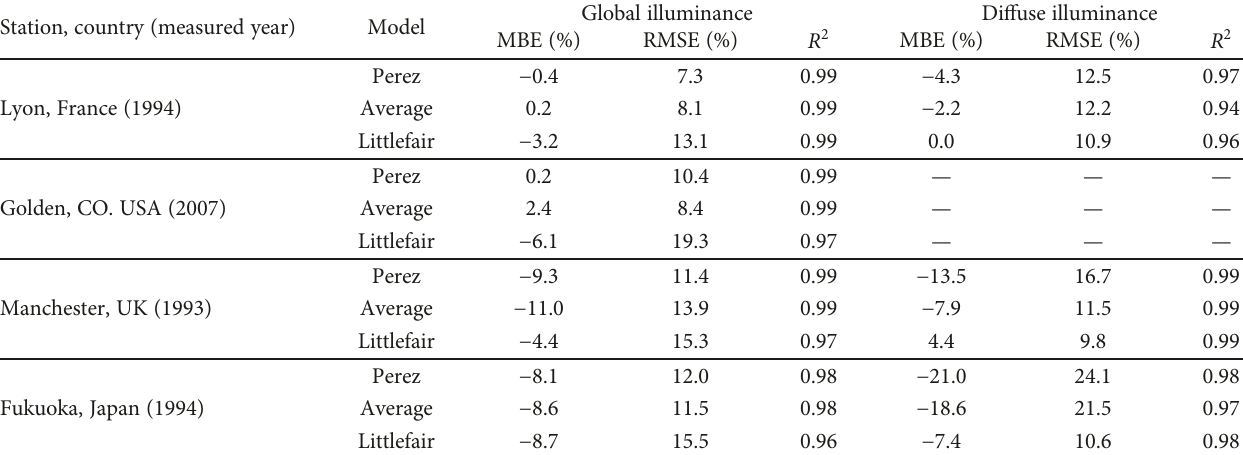
Table 3: Summary of the comparative analysis for selected luminous e ffi cacy models. Station, country (measured year)